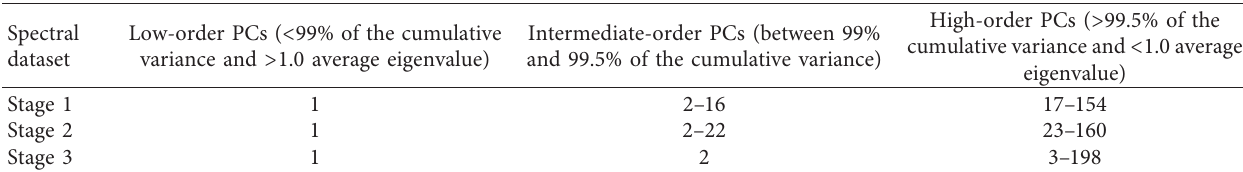
Table 3: Categorization of principal components (PCs) based on their cumulative percentage of total variation and the variance sizes: low-, intermediate-, and high-order PCs.